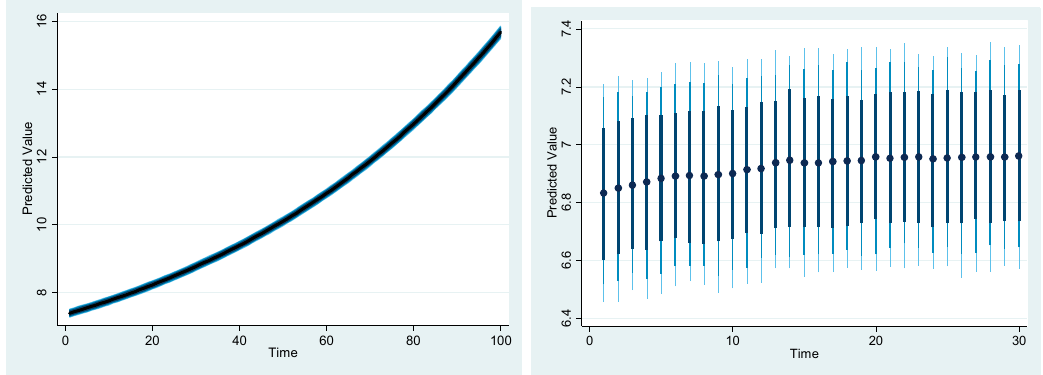
Figure A3. ln_energyln_domln_biocapacity. Note 1: Black dotted line shows average predicted value. Shaded area shows (from darkest to lightest) the 75, 90, and 95 percent confidence intervals. Note 2: Dots show mean change in predicted value from sample mean. Shaded area shows (from darkest to lightest) the 75, 90, and 95 percent confidence